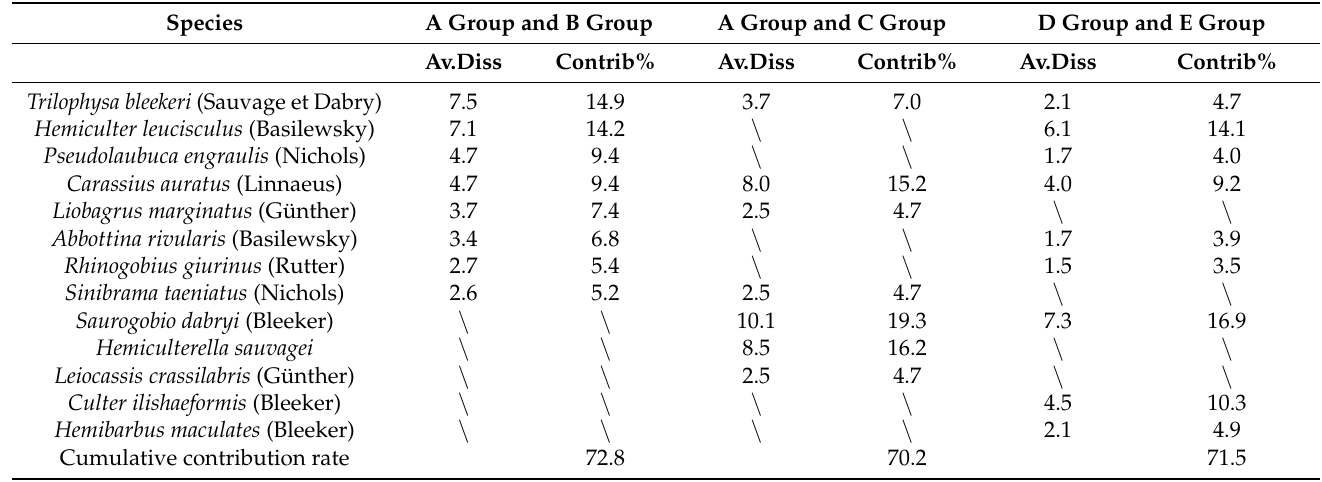
Table 3. SIMPER analysis of five groups of fish communities. Only species which sum > 70% contribution to dissimilarities are presented. “ \ ” indicates no